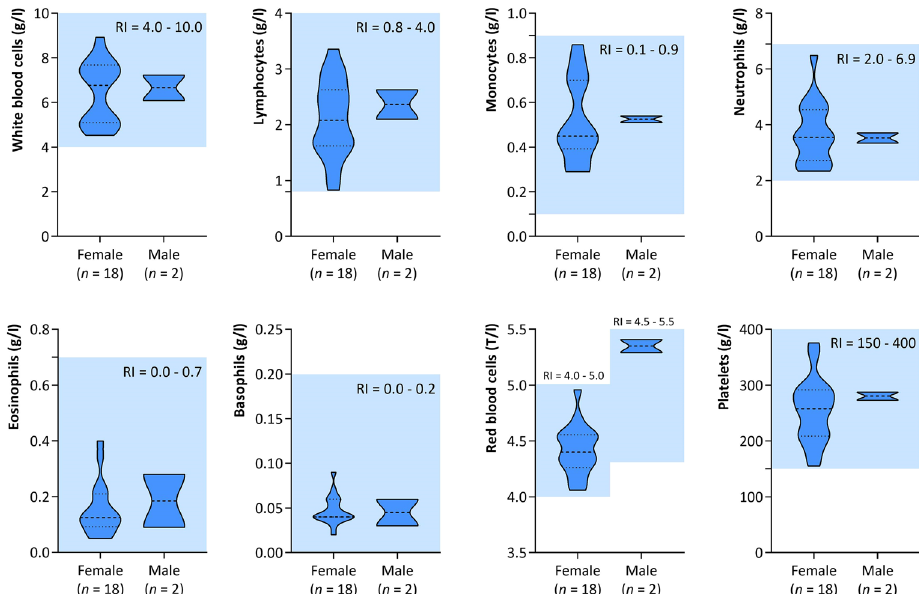
Figure 2. Selected hematological parameters of blood samples isolated from healthy participants ( n = 20). The light blue color mark—the reference interval (RI) for each hematological parameter. Violin plots illustrate the data distribution, median and interquartile